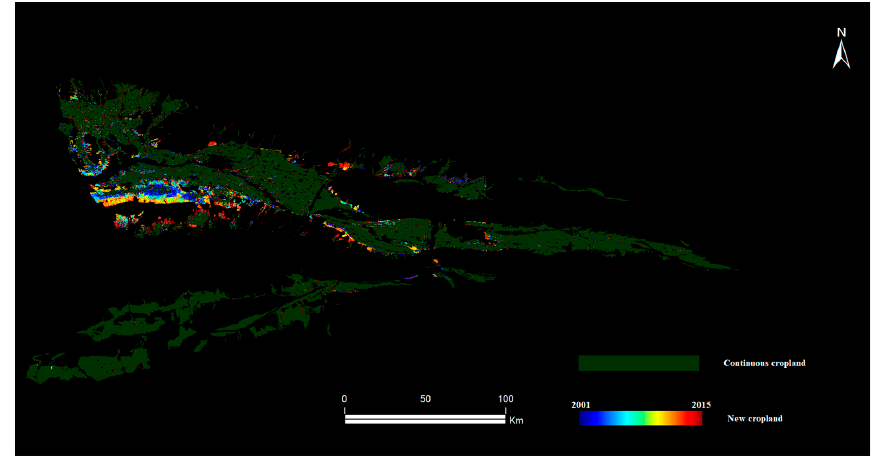
Figure 4. Time series progression of newly reclaimed cropland in the upper Ili River valley of China between the years 2001 and 2015. Previously reclaimed cropland is shown in dark olive green. The image was created by building an annual cloud-free normalized difference vegetation index (NDVI) composite with Landsat-7/ETM + data taken within 3 consecutive years [116] and then repeating this process to generate a cloud-free NDVI time series. This made it possible to design an automatic change detection algorithm to pinpoint the time at which vegetative regrowth occurs. The NDVI time series was examined pixel by pixel to determine the spatio-temporal dynamics of land change at 30 × 30 m resolution. A cropland mask was built with Landsat imagery from 2015 and used to mask out non-agricultural lands.